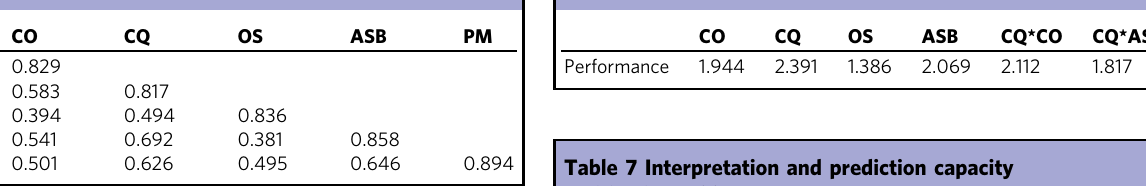
Table 6 VIF analysis table. Table 5 Differential validity test table.